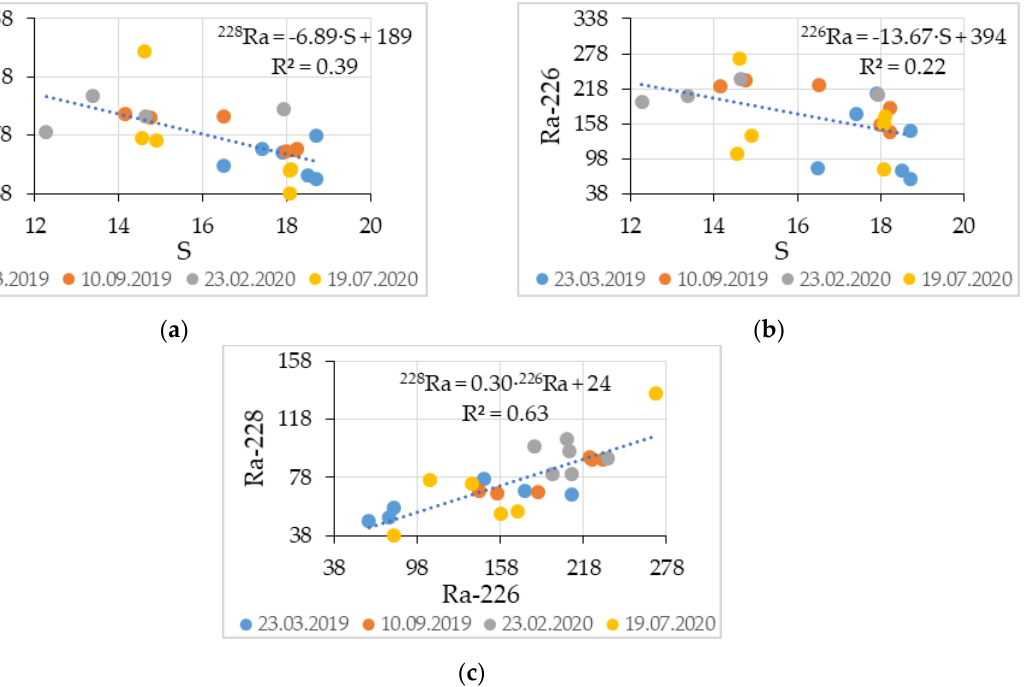
Figure 4. Dependence of the concentration of 228 Ra ( a ) and 226 Ra ( b ), and the ratio of isotopes 228 Ra and 226 Ra ( c ) according to the results of 4